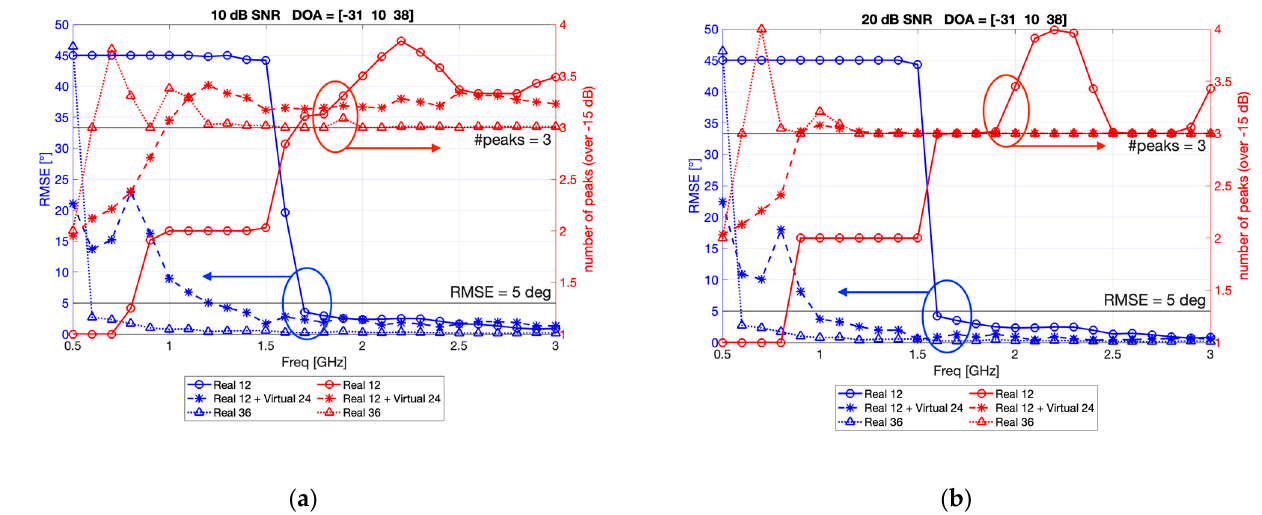
Figure 1. RMSEs obtained from the DOA estimation and the number of peaks when the DOA was − 31, 10, and 38° under ( a ) 10 dB SNR and ( b ) 20 dB SNR.